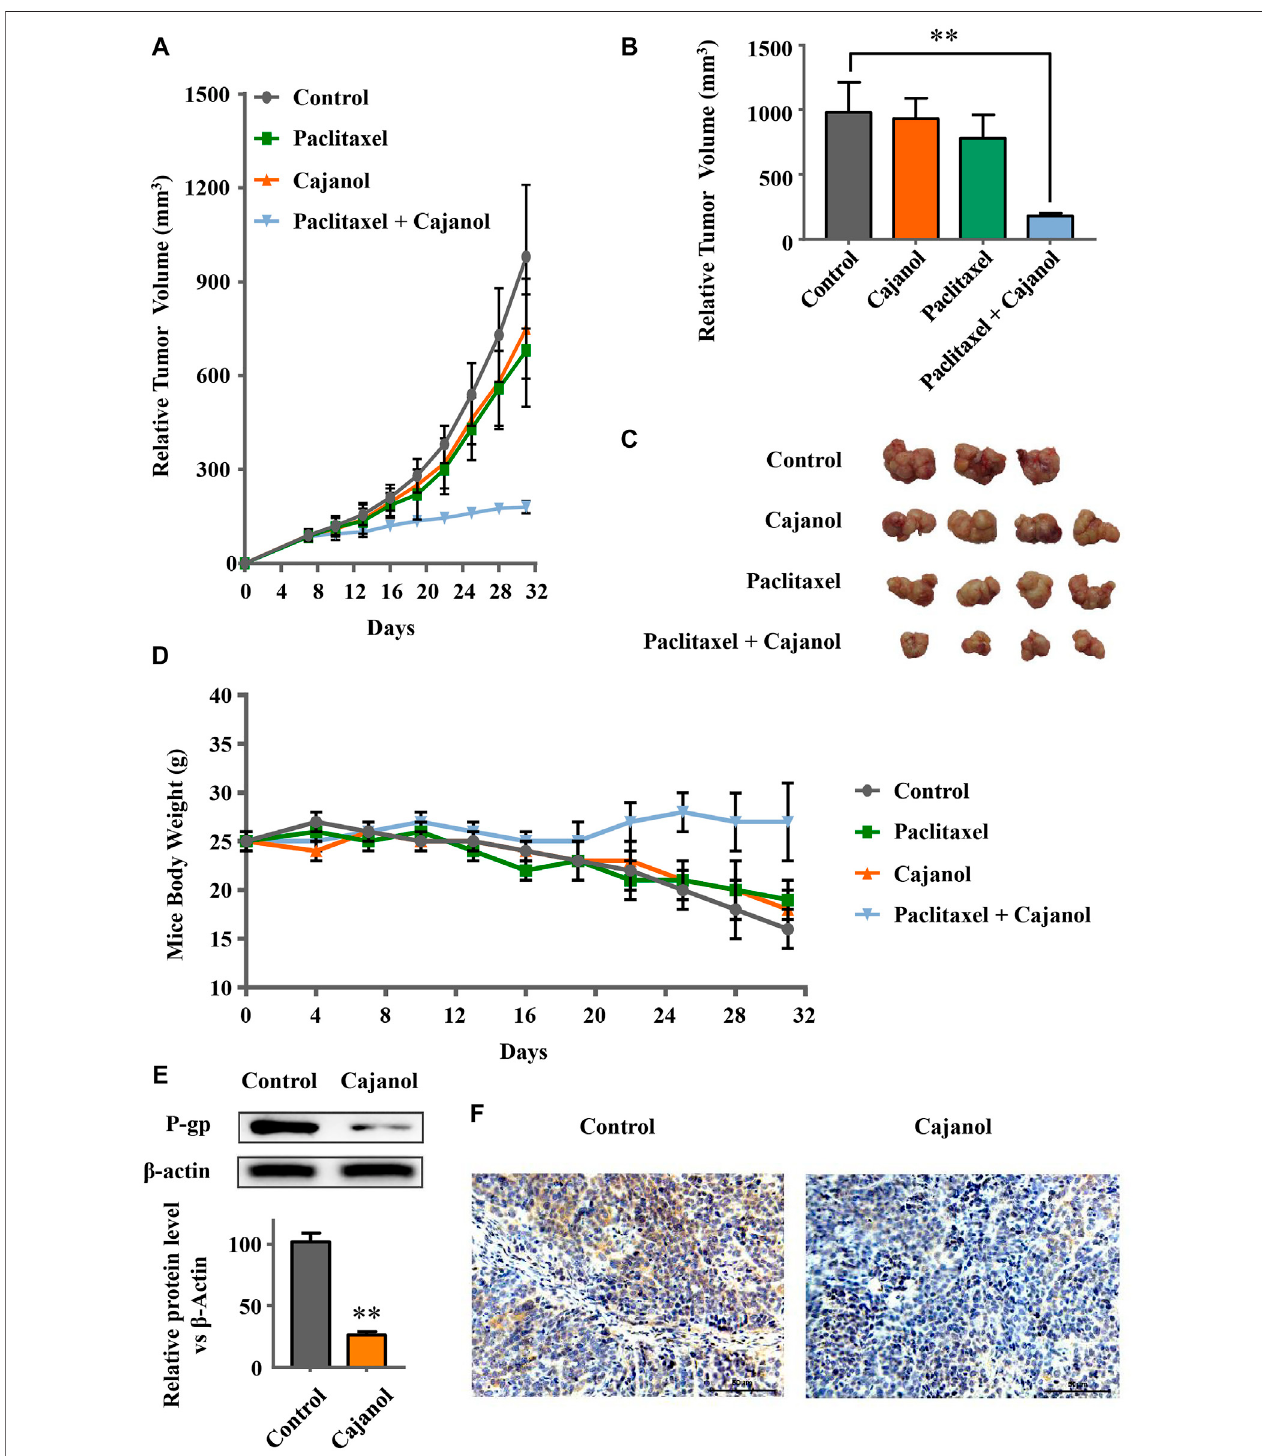
FIGURE 5 | Sensitization of mice to paclitaxel by cajanol. Healthy six-week-old female mice were selected and inoculated with A2780/Taxol cells to form solid tumors.Aftersolidtumorformation,theagentswereadministered onceaweek.Changesinthetumor volumeandbodyweight wereobservedduringthetreatment. (A) Changes in the tumor volume during treatment. (B) Tumor growth ofthe mice in each group after 24 days oftreatment. * p < 0.05 vs control group. (C) Tumor images of the mice after 24 days of treatment. (d) Changes in the body weight of the mice during treatment. (E,F) Effect of cajanol on P-gp expression in tumor tissue as determined by western blot assay and immunohistochemistry. * p < 0.05 vs . control group.